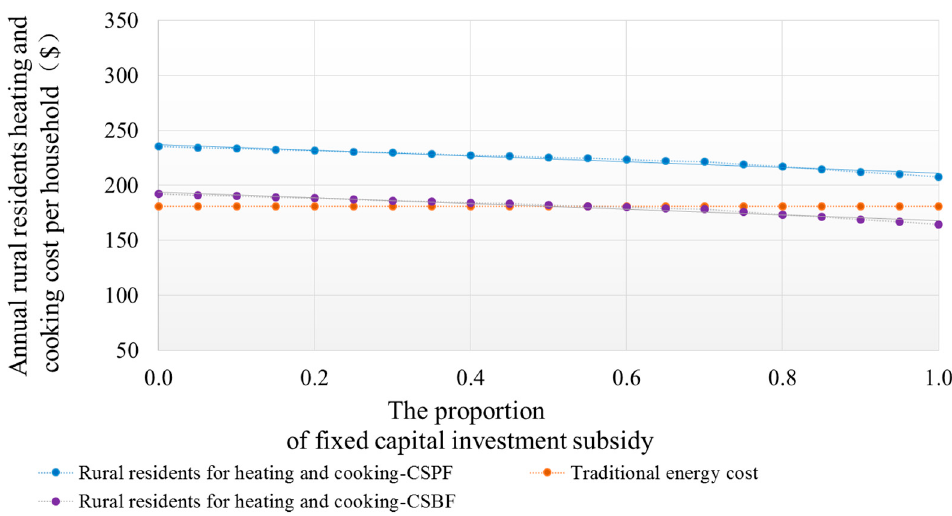
Figure 5. Influence of fixed capital investment subsidy on the economic performance of CSDF for rural residents’ heating and cooking.